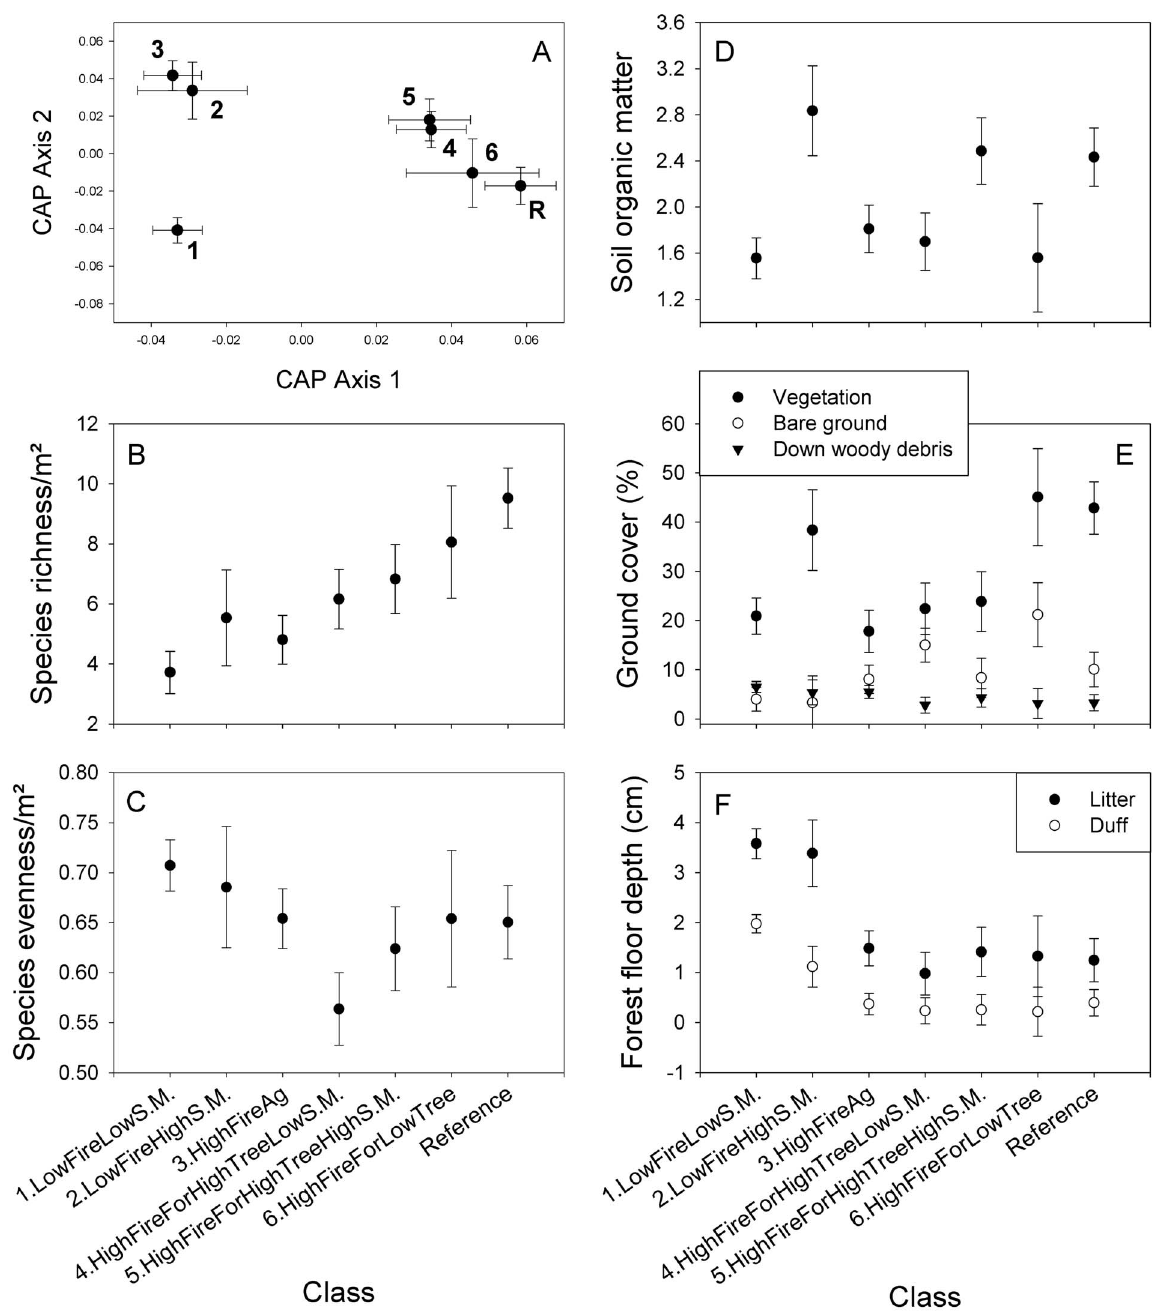
Figure 4. Comparison of Classes (1–6) from the All Sites classification and regression tree analyses to reference conditions. A) Understory community composition, B) understory species richness, C) understory species evenness, D) soil organic matter content, E) ground cover variables, and F) forest floor depth. All values are means 6 95% confidence intervals.